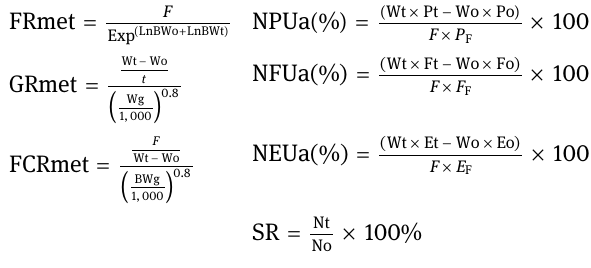
Table 2: FCRmet of Tilapia larvae cultured in RAS and BFS calculated